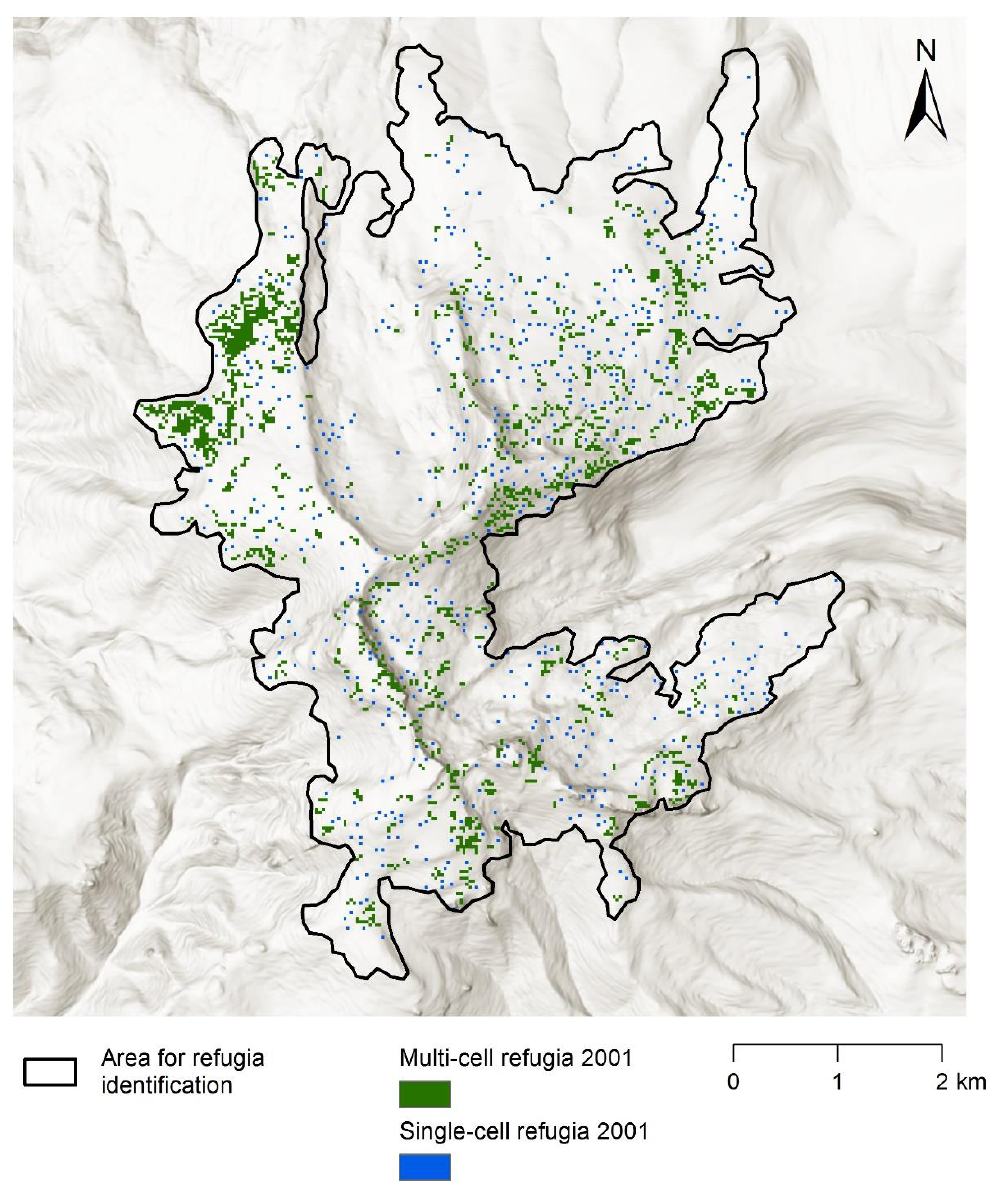
Figure A1. Refugia identified in 2001 (10% of grid cells, stratified by forest type, that had the highest NDMI anomalies in 2001) and multi-cell refugia identified in 2001 (clusters of two or more contiguous grid cells identified as refugia in 2001).